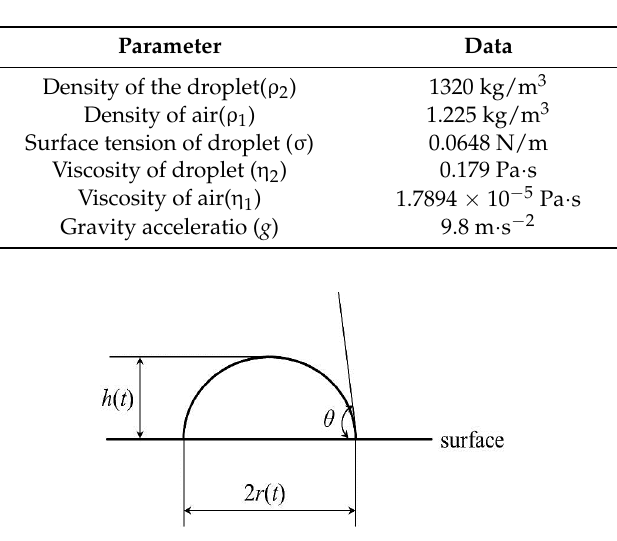
Figure 2. A typical triangular mesh of the domains. Table 1. Material properties.